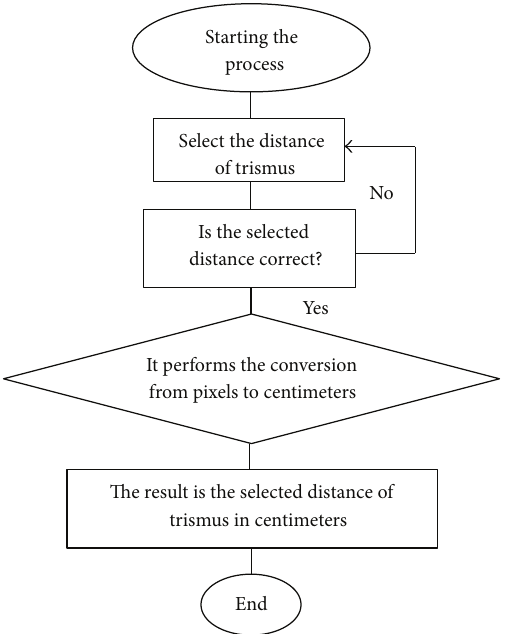
Figure 7: Algorithm used to convert pixels to